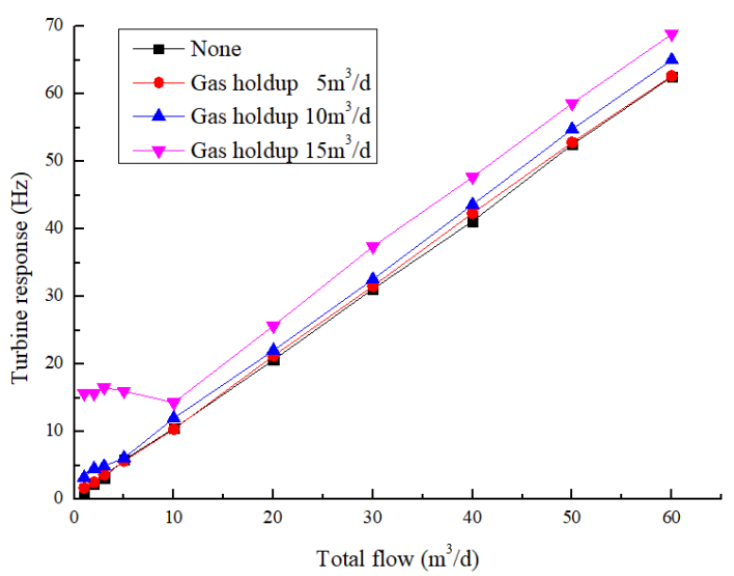
Figure 18. Output frequency curve of turbine flowmeter with different gas phase flow in water holdup 70% and oil holdup 30%.